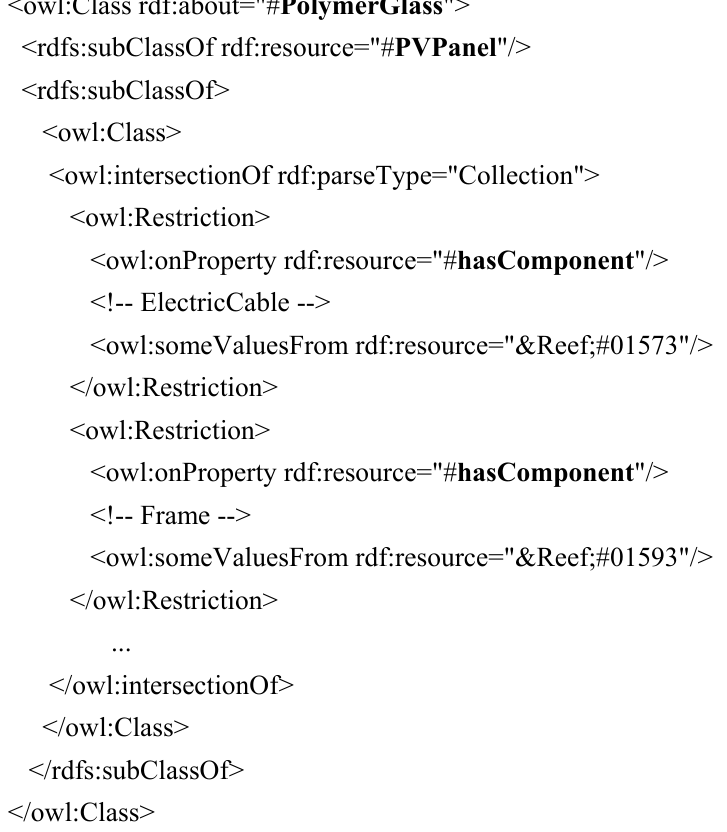
Figure 1. Example of owl code used to define a